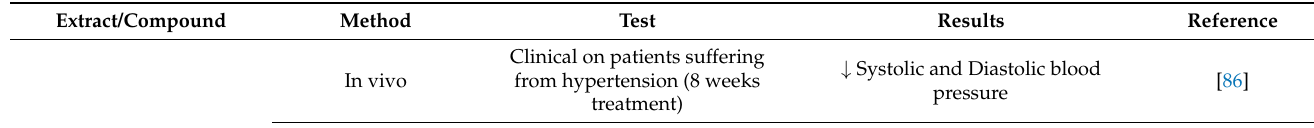
Table 5. Summary of the cardioprotective activities of